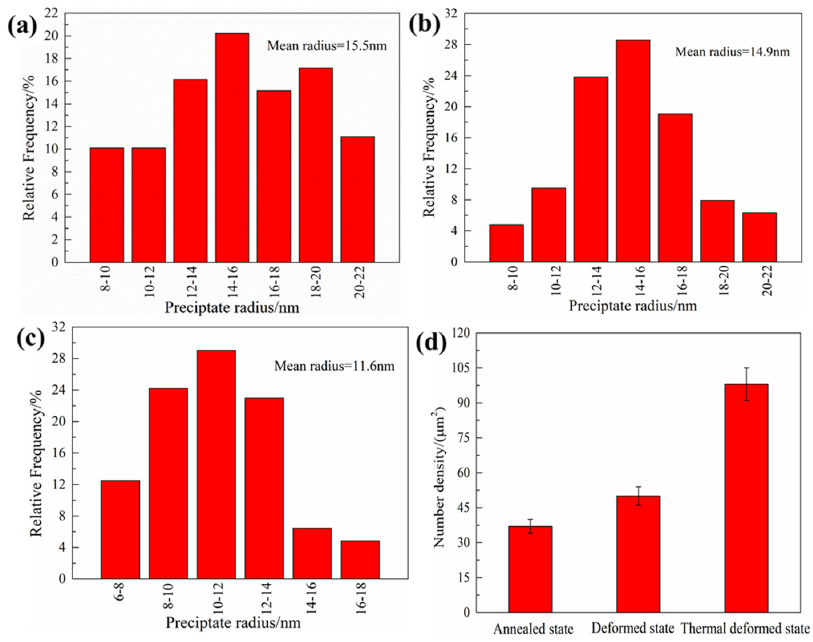
Figure 9. Histogram of Al3Zr dispersoids size distribution and number density of three different homogenized samples: ( a ) AS sample; ( b ) DS sample; ( c ) TDS sample; ( d ) number density.